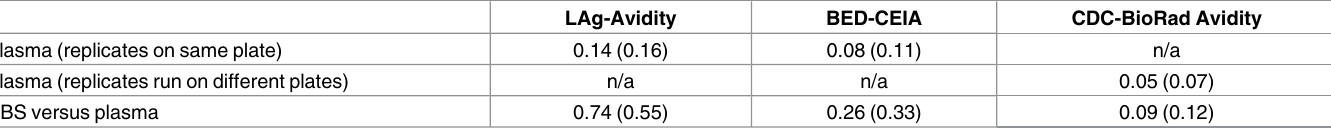
Table 3. Averagedifferences (standard deviations) of replicate plasma samples and matched plasma and DBS samples tested with LAg-Avidity, BED-CEIA, and CDC-BioRad Avidity.